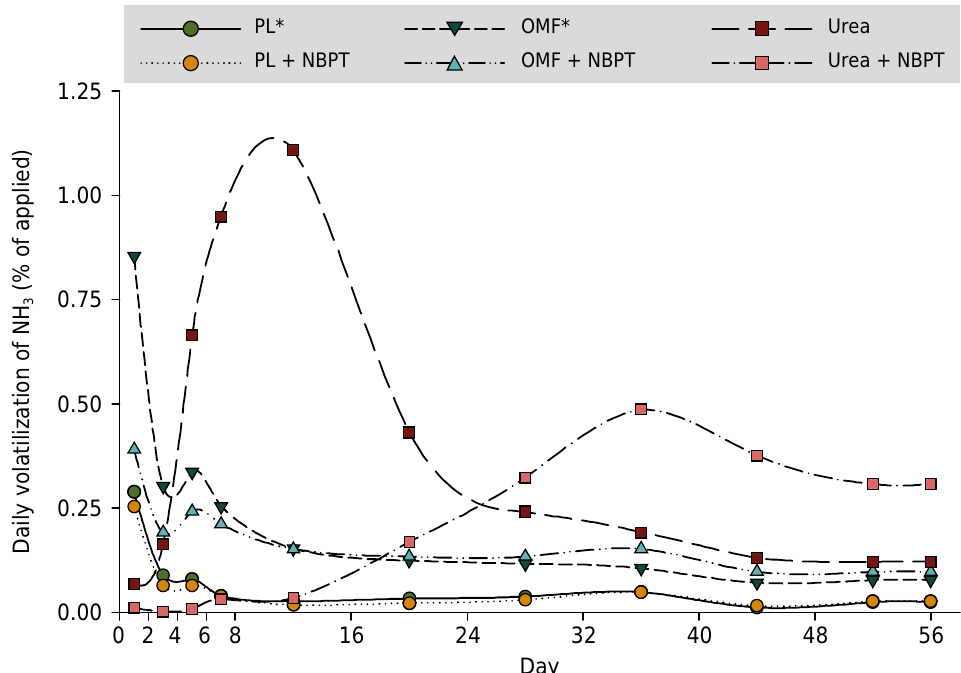
Figure 3. Daily volatilization of ammonia in relation to the total N applied, following application of 200 mg kg -1 N at the soil surface from nitrogen fertilizers, in the presence or absence of N-(n-butyl) thiophosphoric triamide (NBPT). Values were subtracted from those volatilized from the treatment that did not receive N (control). PL*: Poultry litter; OMF*: organomineral